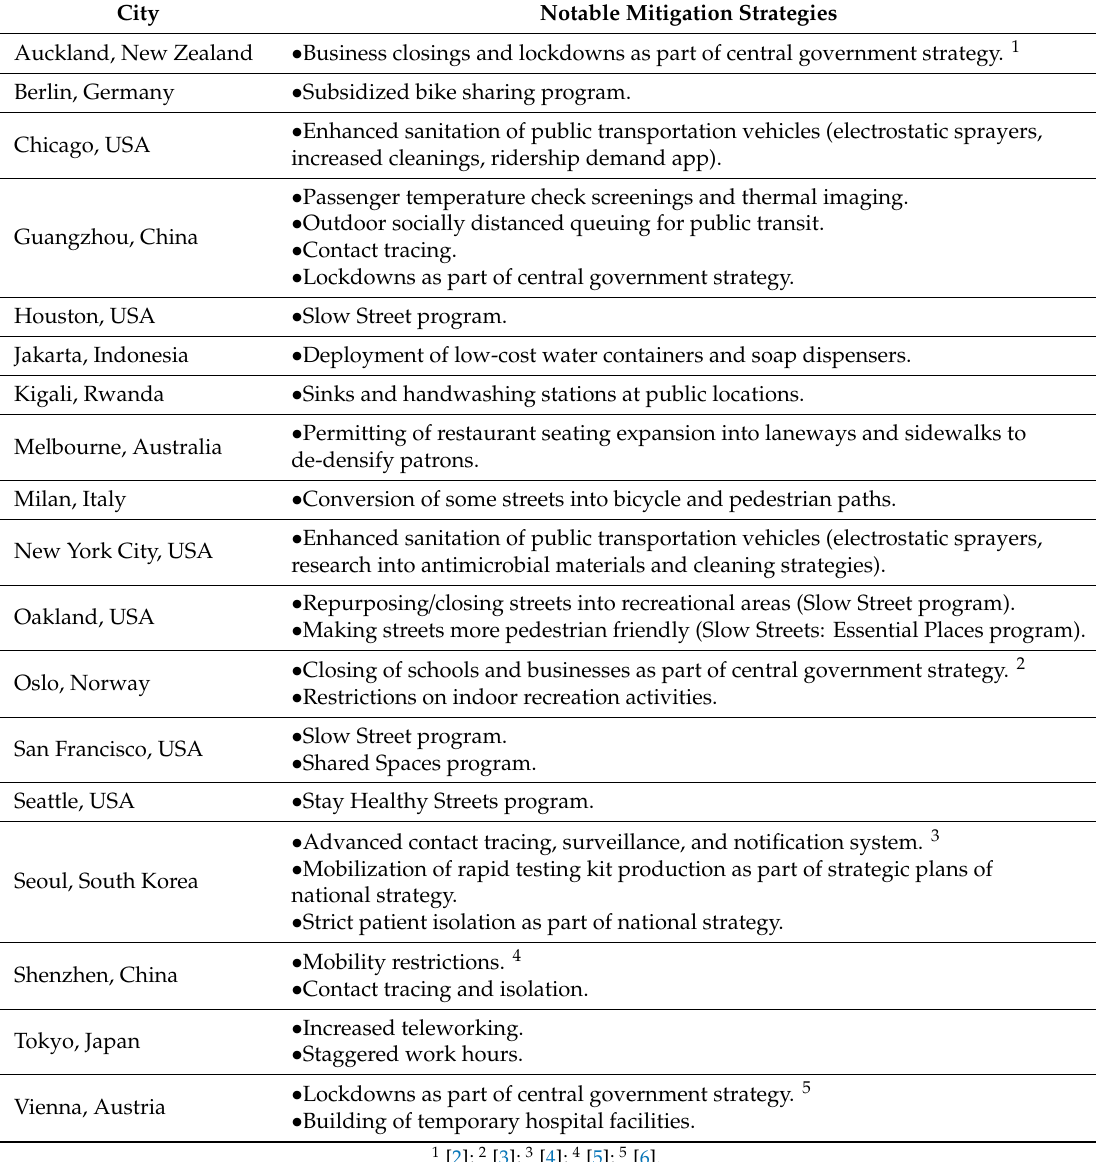
Table 1. COVID-19 mitigation